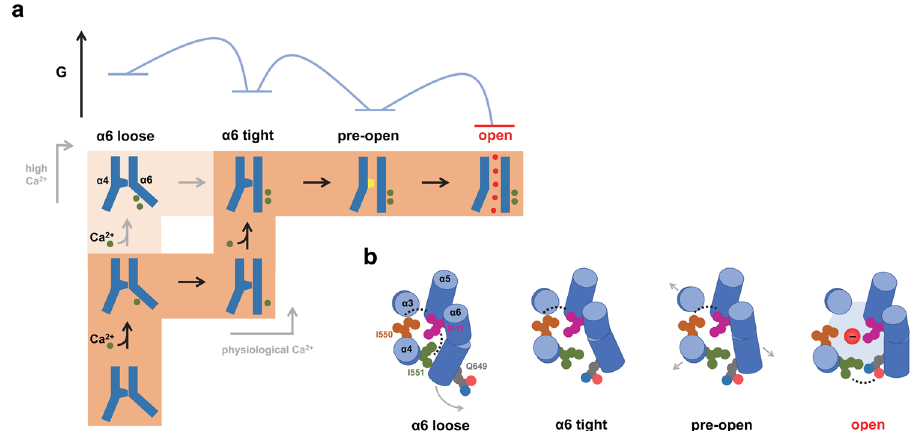
Fig. 7 Activation mechanism. a Cartoon depiction of the activation mechanism. The states are as in Fig. 1d. Inset (top) shows a schematic representation of the energy maxima in the gate region between connected states. The relative location of the transition states was obtained from phi value analysis. The two alternative pathways for activation at physiological and at high Ca 2 + concentrations are indicated. b Schematic depiction of the relationship between residues of the gate region in different steps during activation. The view is from the extracellular side. Gate residues located on α 4 (Ile 550 and Ile 551) retain their interaction with the gate residue Ile 641 on α 6 in the transition between the three closed conformations although the interaction between Ile 551 and Ile 641 successively weakens until it is replaced by an interaction with Gln 649 upon transition into the open state where the gate has dissociated and the pore has dilated to permit ion